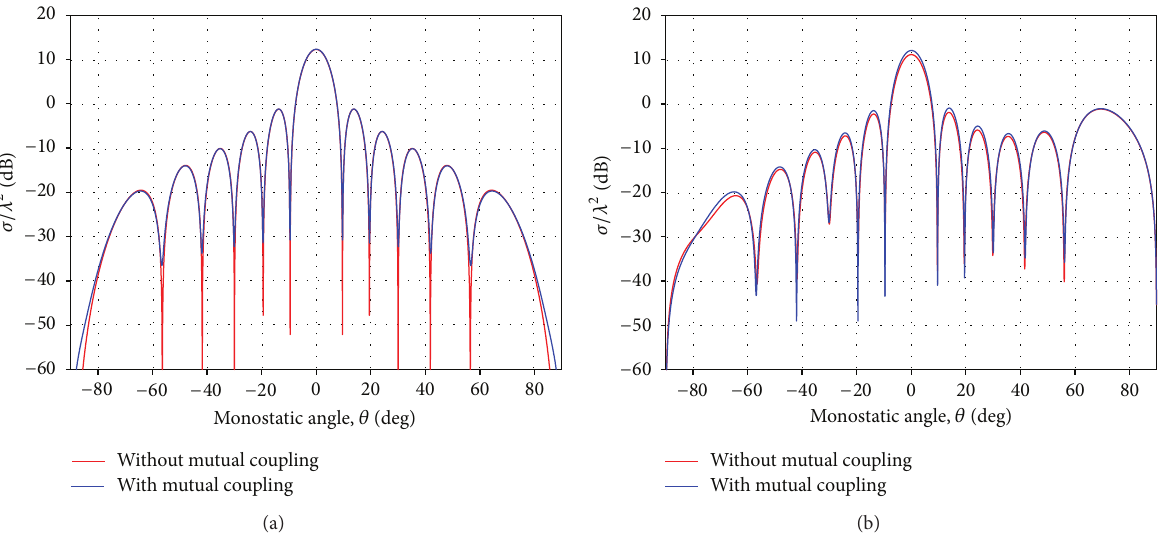
Figure 9: Effect of mutual coupling on RCS of series-fed linear collinear dipole array of 𝑁 = 30 , 𝜓 = 𝜋/2 , 𝑑 = 0.1𝜆 , 𝑙 = 0.5𝜆 , 𝑎 = 10 −5 𝜆 , = 75Ω , and 𝑍 = 150 Ω ; unit amplitude uniform distribution. (a) 𝜃 𝑍 0 𝑙